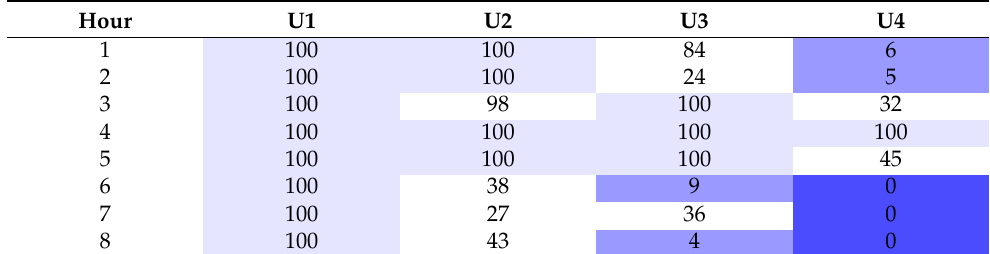
Table 2. Example of